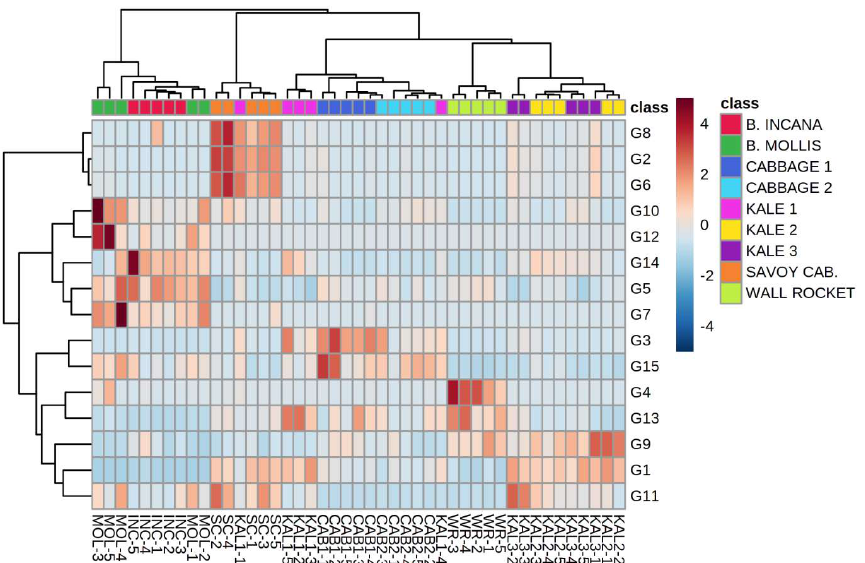
Figure 3. Clustering of Brassicaceae species by hierarchical cluster analysis (HCA) based on the composition of volatile compounds generated in the glucosinolate (GSL) pathway. The rows in the heatmap diagram represent compounds and the columns represent samples. Codes indicating compounds that correspond to those reported in Table 1. Colors of the heatmap cells indicate low (dark blue), medium (white), and high (dark red) abundance of a particular compound. PLS-DA applied on GSL volatiles data resulted with a relatively good separation of the three categories: cabbage landraces, kale accessions, and wild species (Figure 4a). Two volatile compounds with the highest VIP scores, allyl nitrile (G21) and 4-methylpentanenitrile (G3), were most abundant in cabbage (Figure 4b). Among other